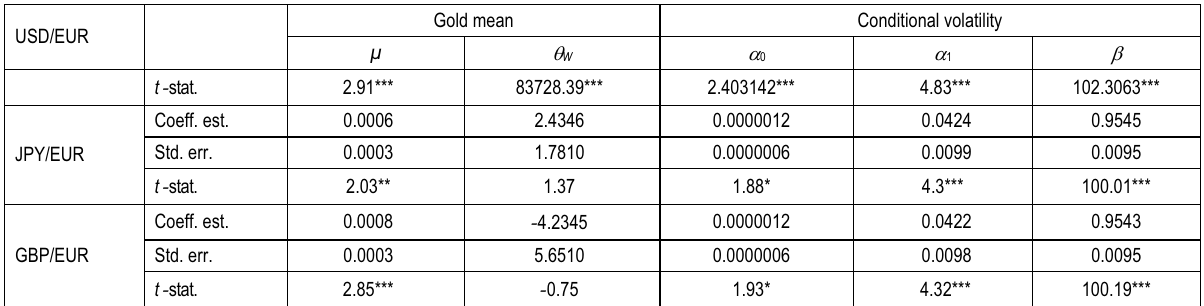
Table 5 (cont.). Estimation results for Euro exchange rates Results of GARCH-X (1,1) model with mean equation of gold returns depending on Euro exchange rate returns’ volatility.